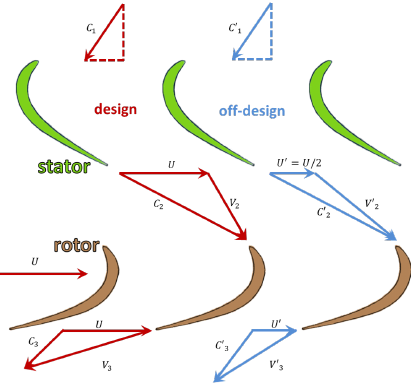
Figure 1. Representative flow velocity triangles through the stator–rotor passage for design and off-design conditions under variable speed power turbine operation.